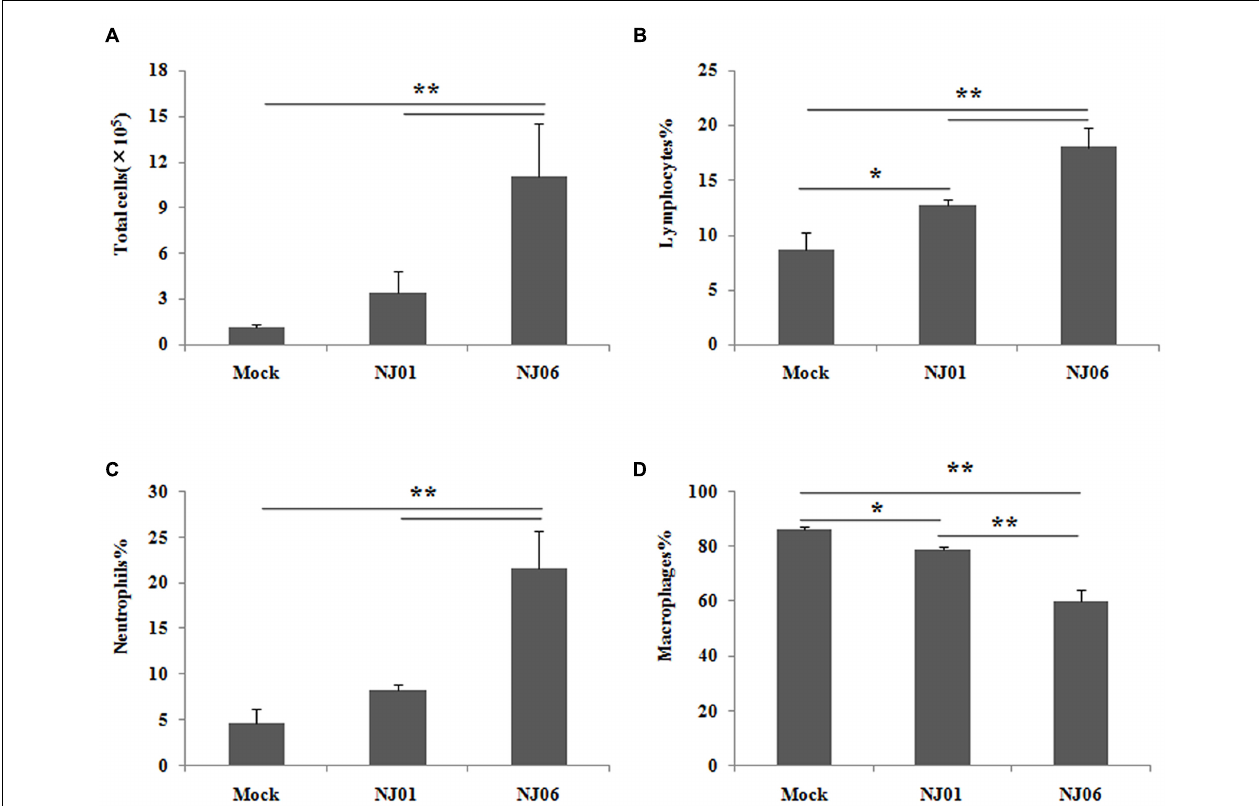
FIGURE 4 | Total and differential cell counts in bronchoalveolar lavage (BAL) fluid. Groups of five mice were inoculated intranasally with 10 5 EID 50 of NJ06 or NJ01 virus, and BAL specimens were collected to determine cell counts on 5 dpi. The total numbers of BAL cells (A) and percentages of lymphocytes (B) , neutrophils, (C) and macrophages (D) of virus- or mock-inoculated mice are shown as means ± SD. ∗ p < 0.05 and ∗∗ p <